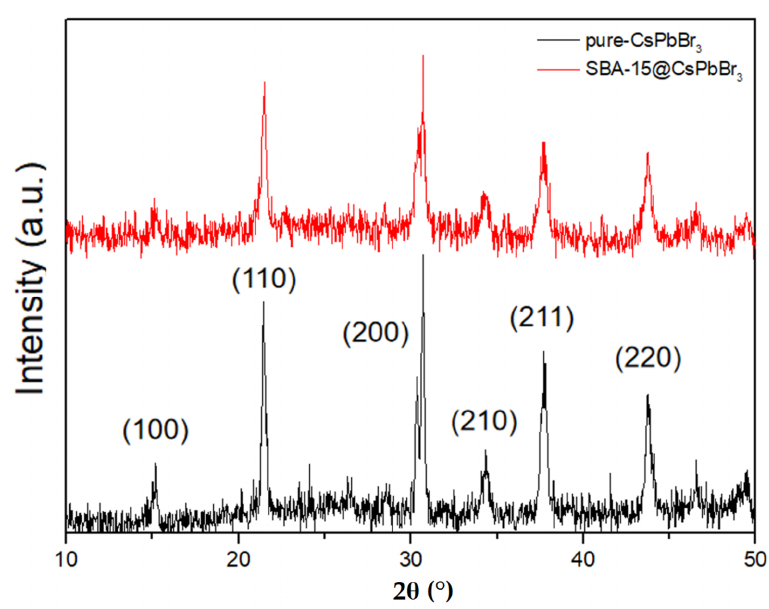
Figure 5. XRD pattern of pure CsPbBr 3 QDs (black) and SBA-15@CsPbBr 3 QDs (red).